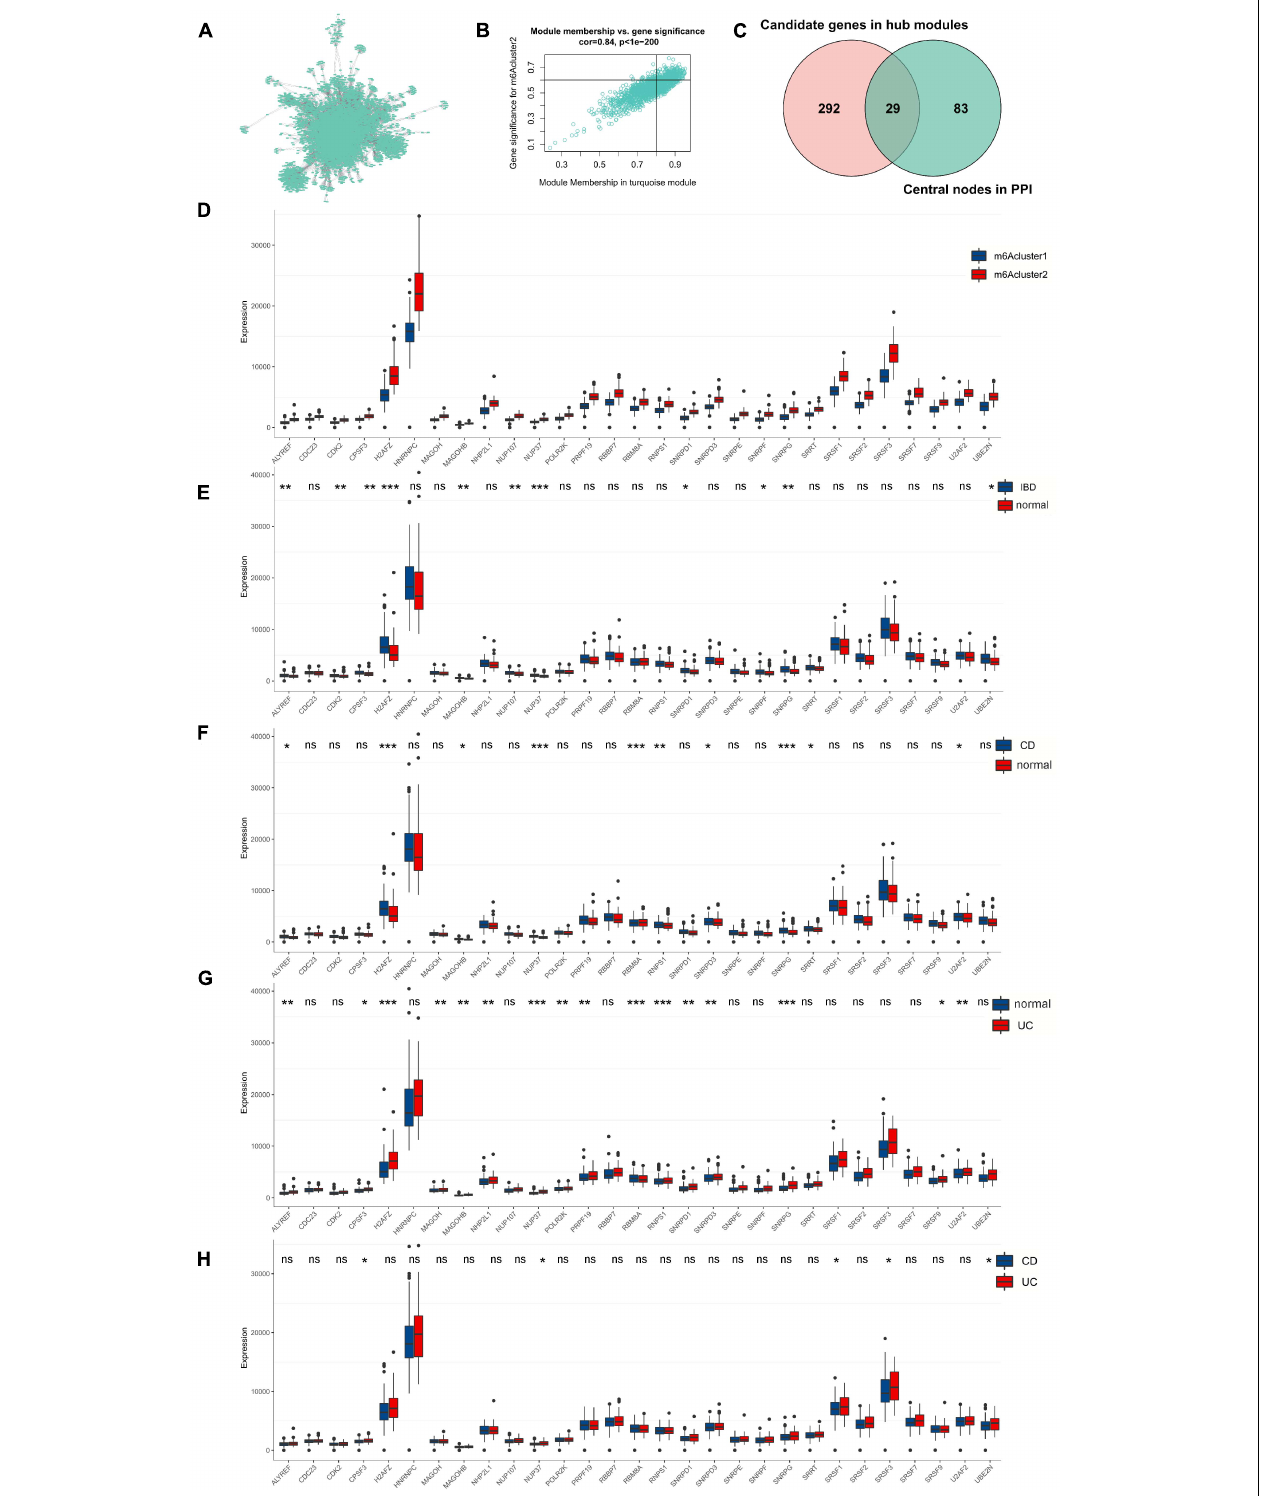
FIGURE 4 | Twenty-nine m 6 A phenotype-related hub genes affect disease characteristics in IBD. (A) The PPI network of genes in the key module. (B) The significance genes in the turquoise module. (C) The hub genes of the interaction network are intersected with the hub genes identified in the m 6 A-related module. (D) The 29 genes’ expression in different m 6 Acluster classification. (E–H) The 29 genes’ expression between normal, UC, and CD tissues. The asterisks represented the statistical P -value (* P < 0.05; ** P < 0.01; *** P < 0.001).